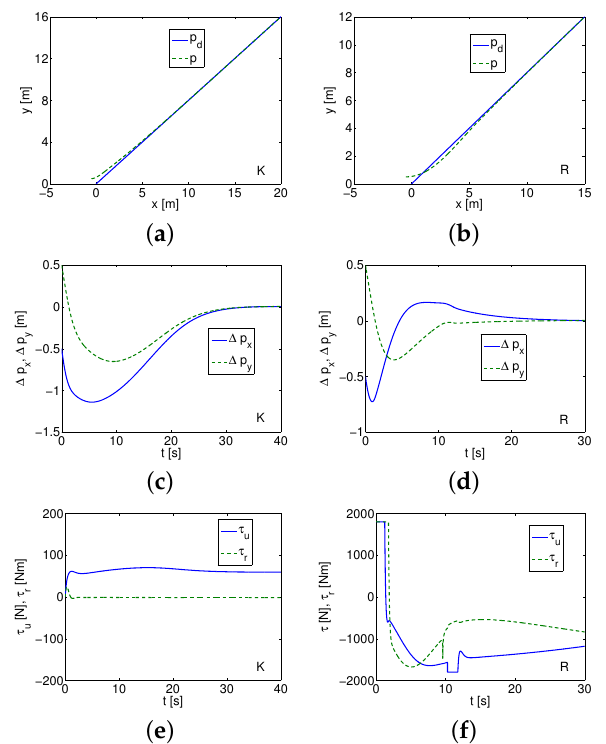
Figure 12. Simulation results for SMC/backstepping Kambara (K) and TSMC ROPOS (R)—linear trajectory. ( a , b ) Desired and realized trajectory; ( c , d ) position errors; ( e , f ) applied